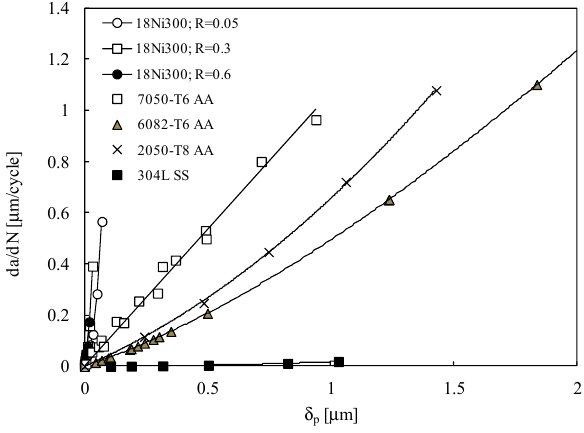
Figure 9. FCGR versus plastic CTOD, δ p , for di ff erent